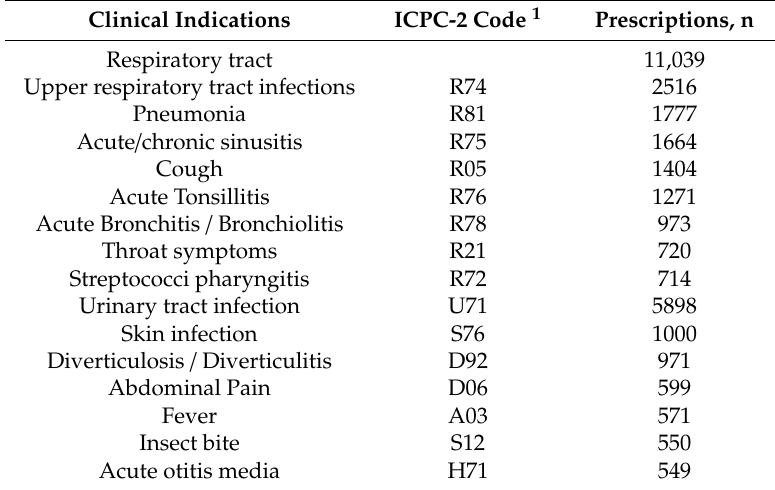
Table 2. Top 15 clinical indications for antibiotic prescribing in Swiss primary